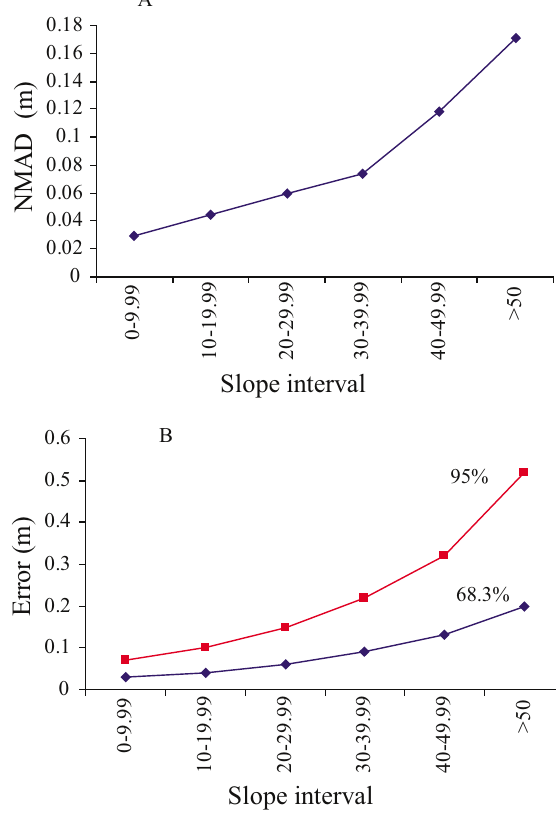
Fig. 4. The relationship between the slope of the terrain and the errors in the estimated elevation. The Figure A illustrates the NMAD for all data as a function of slope interval, while the Figure B shows the results for the 68.3% and 95% quantiles of the errors. Both Figures are based on a resolution of 0.5